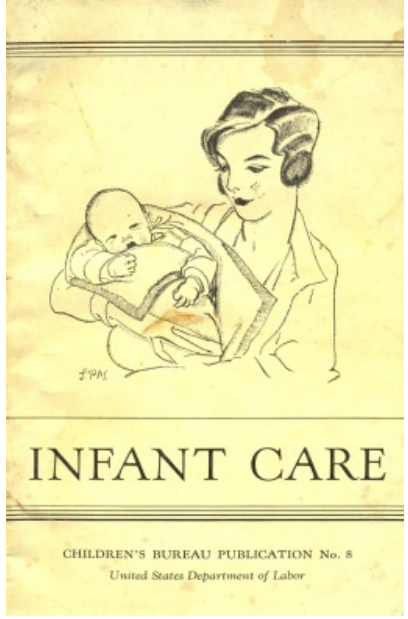
Figure 32. Front Cover of 1935 edition of Infant Care .